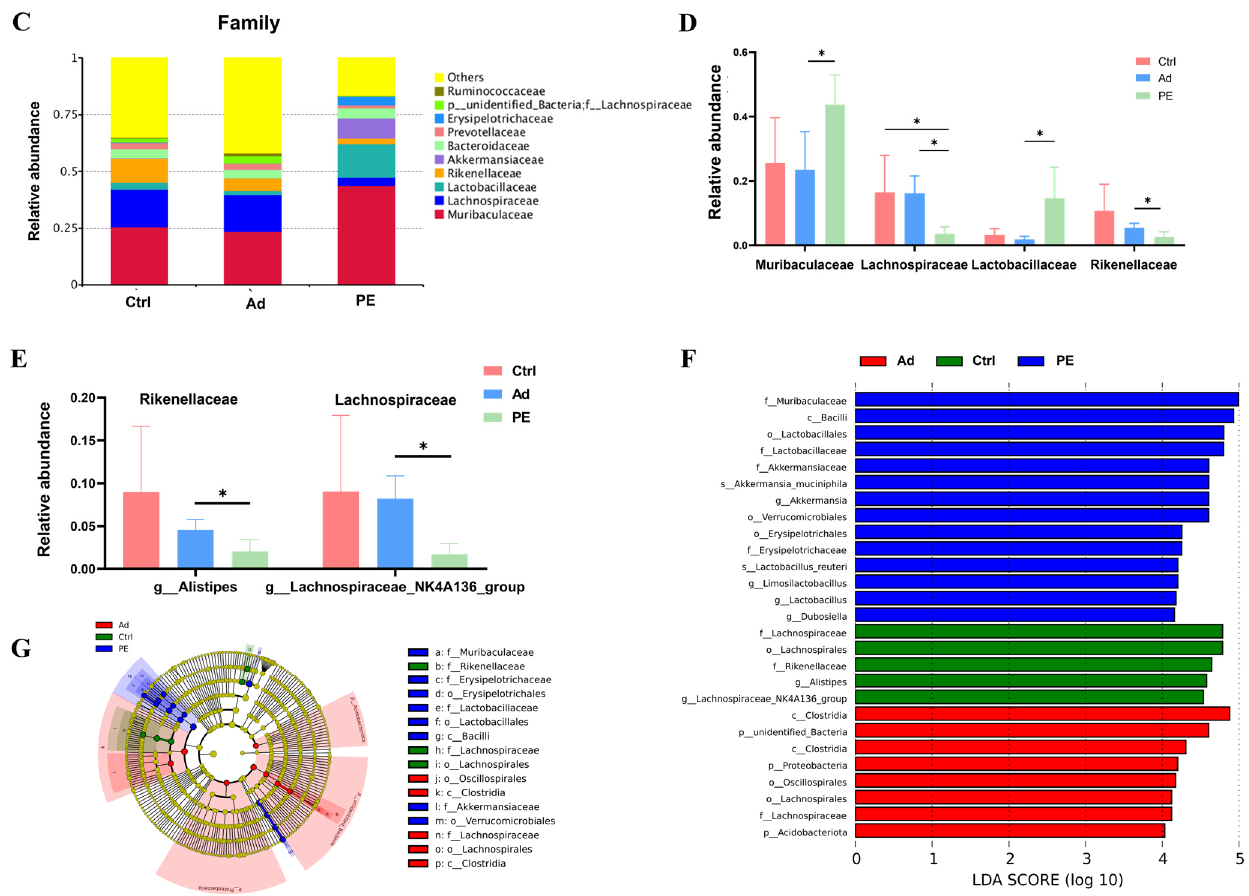
Figure 6. The composition of gut microbiota at different taxonomic levels in the colons in mice ( n = 6 for PE group; n = 5 for Ad and Ctrl groups). ( A ) Relative abundance of gut microbiota at the phylum level. ( B ) Relative abundance of bacterial phyla with significant differences based on the q value. ( C ) Relative abundance of gut microbiota at the family level. ( D ) Relative abundance of bacterial families with significant differences based on the q value. ( E ) Relative abundance of Alistipes and Lachnospiraceae_NK4A136_group . ( F ) LDA score (LDA score threshold > 4). ( G ) Taxonomic cladogram. ns: no significance; *: q < 0.05; **: q < 0.01.